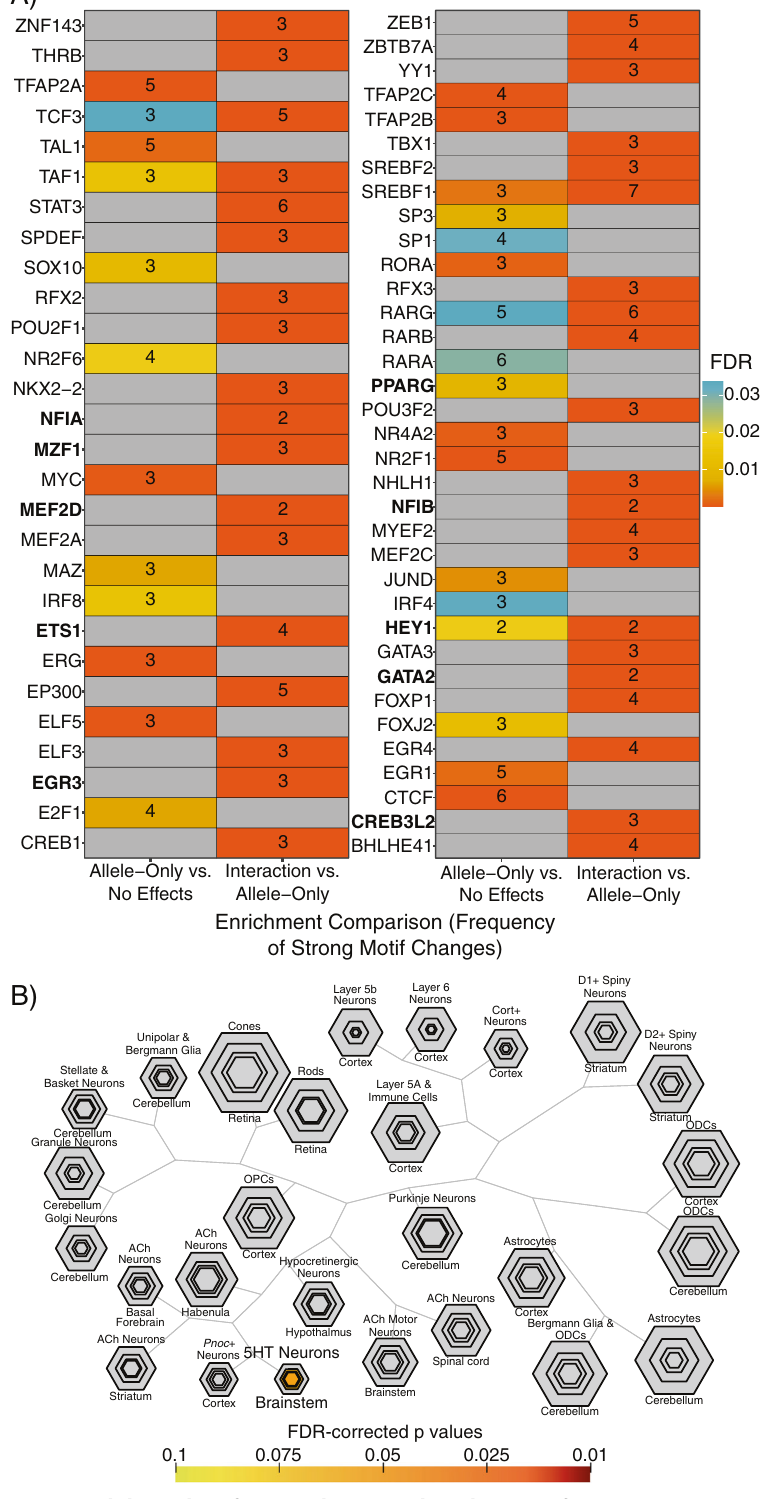
Fig. 5 Distinct TFs underlying retinoid-dependent functional SNPs and implication of serotonergic neurons. A Motifs overrepresented among ATRA-independent (allele effect without interaction) SNPs (left columns) or among ATRA-dependent (interaction) SNPs (right column). The heatmap is shown in halves for visibility. TFs identi fi ed as ATRA-upregulated in human neuroblastoma lines [104] are in bold font. B TFs implicated by ATRA-interacting SNPs signi fi cantly overlap TFs enriched in serotonergic neurons. Plot generated using the cell-speci fi c expression analysis (CSEA) tool (http://genetics.wustl.edu/jdlab/csea-tool-2/) [32]. 5HT serotonin, ACh acetylcholine, ODC oligodendrocyte, OPC oligodendrocyte